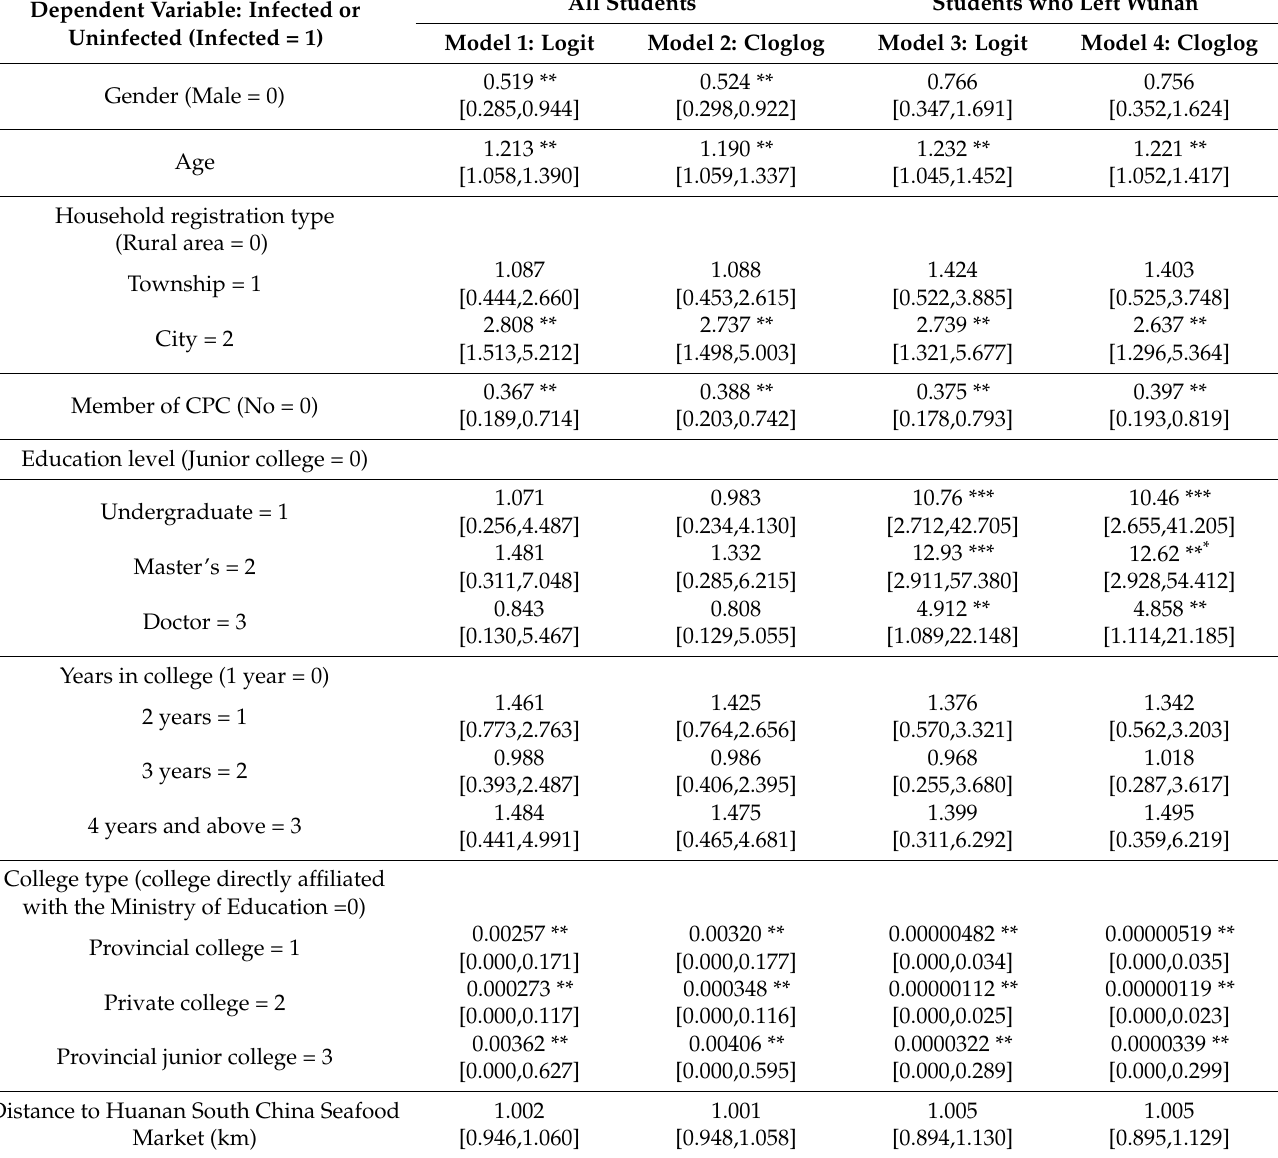
Table 6. The robust regression analysis of logit and cloglog of confirmed infection among college students in